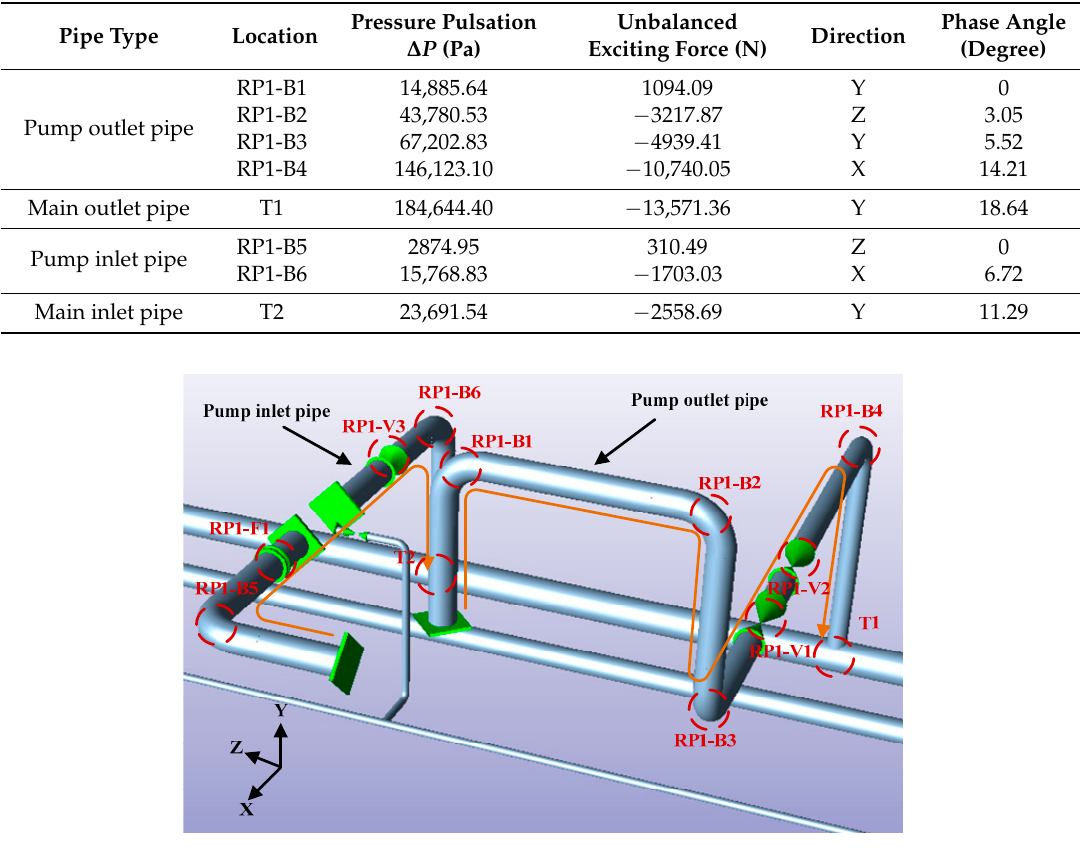
Table 6. Calculation results of unbalanced exciting force of RP1 pump pipe.